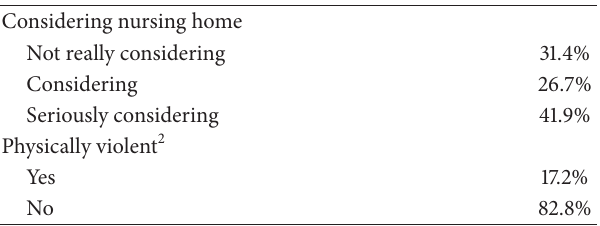
Table 1: Caregiver demographics ( 𝑁 = 254